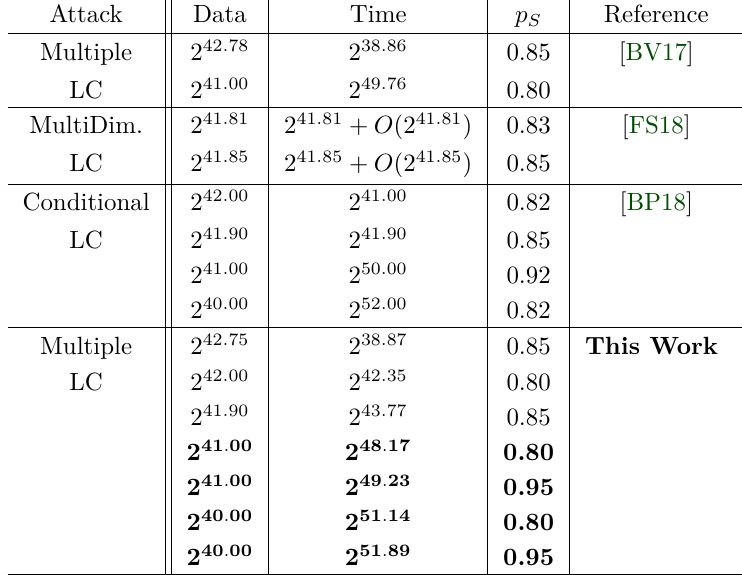
Table 1: Comparison of Recent Attacks on